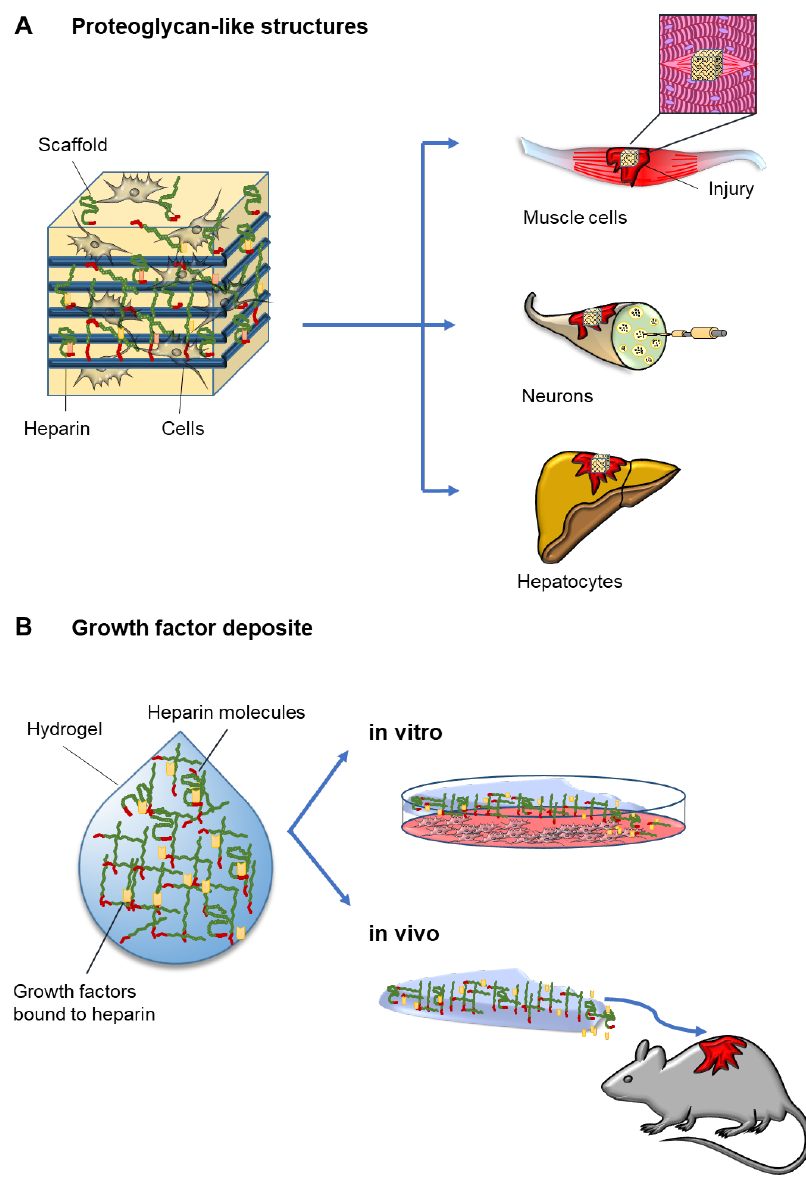
Figure 2. Heparin-based biomaterials for regenerative medicine. ( A ) Biodegradable scaffolds conju- gated with heparin provide a proteoglycan-like structure. This mimics the physiologic functions of heparan sulfate, supporting proliferation and differentiation of muscle cells, neurons and hepato- cytes. ( B ) In heparin-modified hydrogels and scaffolds, heparin molecules are frequently conjugated with growth factors and/or cytokines. These factors are slowly but constantly released during the degradation of the biomaterial and thus support cell proliferation and differentiation in vitro and in vivo.